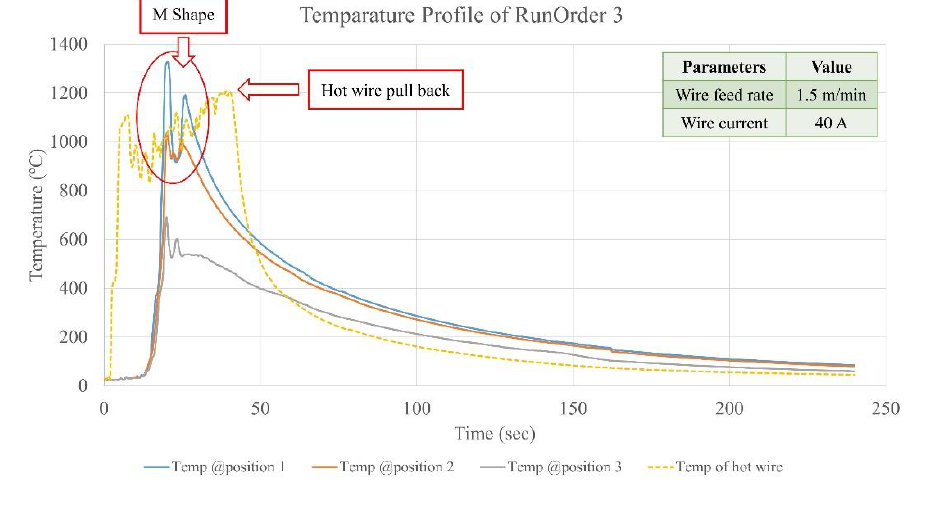
Figure 10. The temperature profile of run order 3.